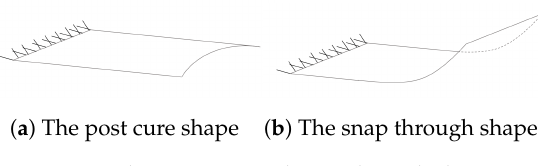
Figure 4. The post cure and snap through shapes.